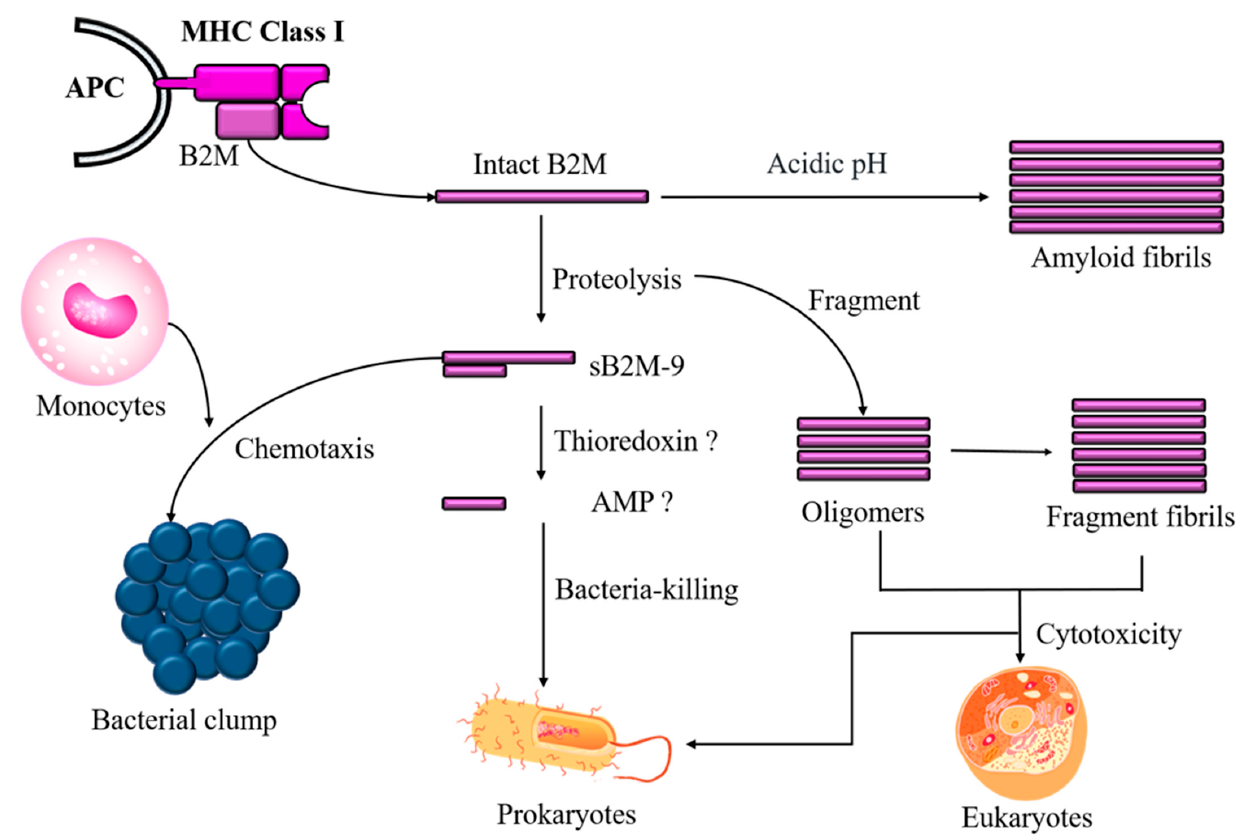
Figure 2. Diagram for B2M as a precursor of sB2M-9 chemokine and perhaps as a potential AMP. B2M that is at an increased level at either the intact or fragmented state under an acidic pH is prone to structural aggregation and possibly into amyloid fibrils that cause cytotoxicity and membrane disruption in eukaryotic cells; this effect is similar to that of AMP, which usually forms pores on microbe membranes.